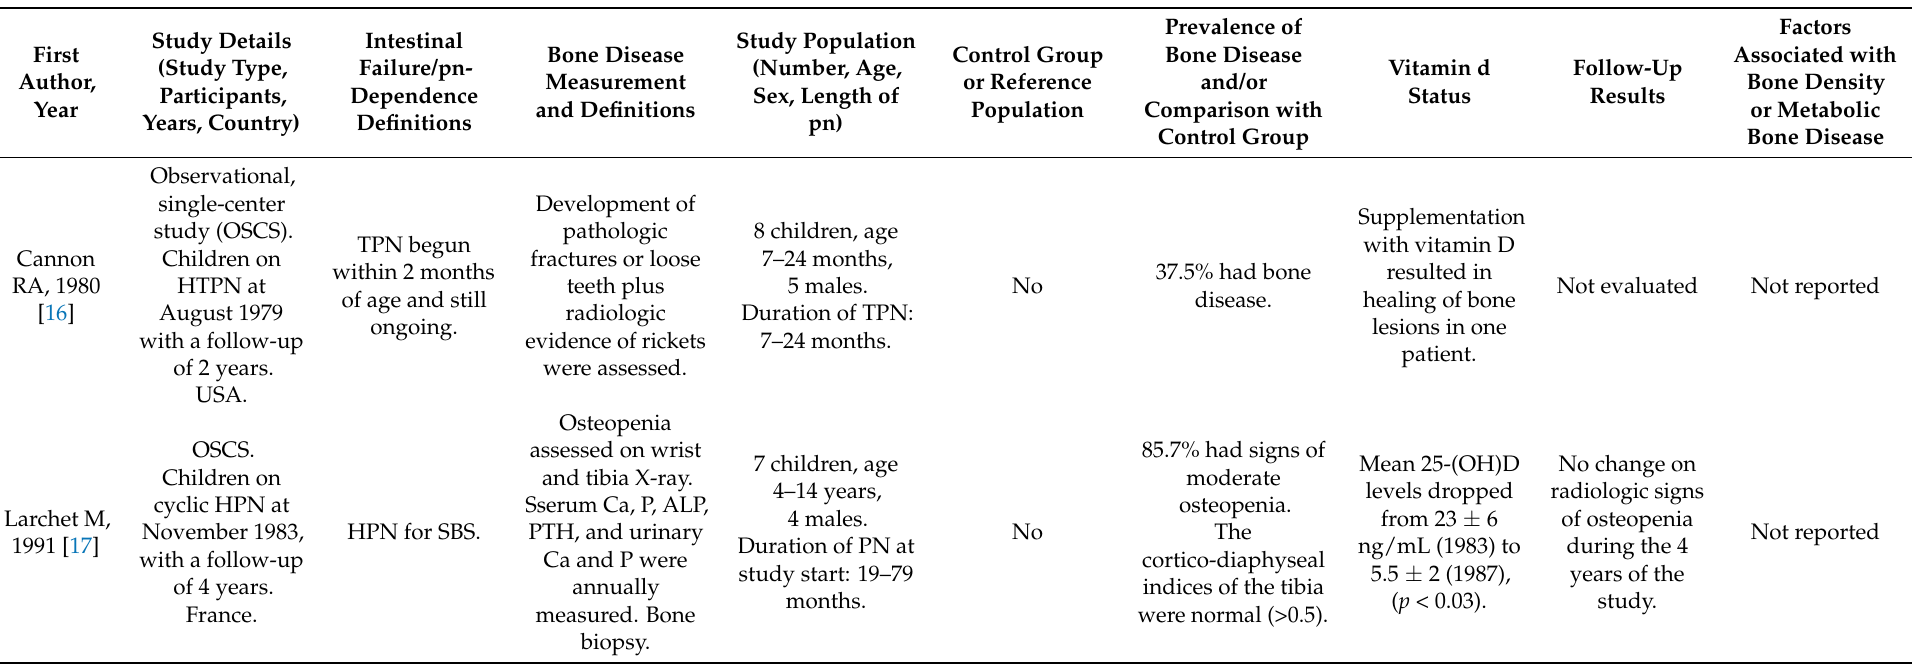
Table 2. Main characteristics of the included